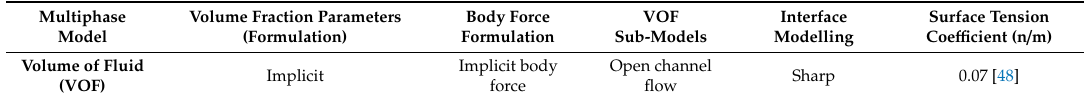
Table 3. Multiphase modelling set-up.